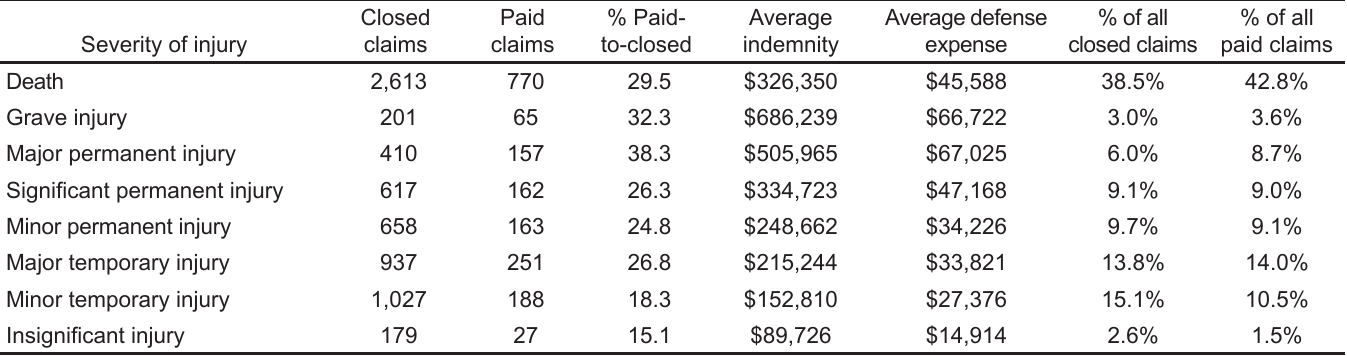
Table 5. Outcomes according to severity of injury cited in closed claims in adult emergency departments or urgent care